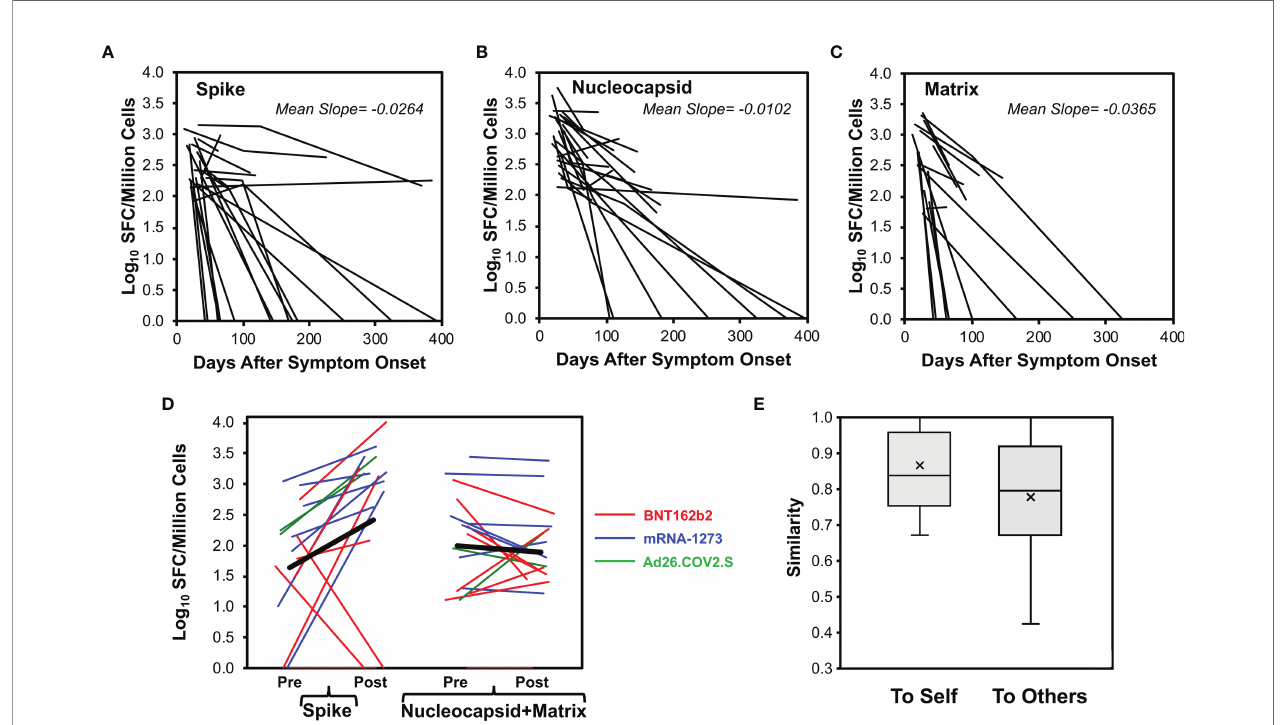
FIGURE 4 | CD8 + T cell responses decay after SARS-CoV-2 infection but vaccination boosts memory against spike protein. CD8 + T cell responses were measured longitudinally by ELISpot assay in 29 persons monitored starting early SARS-CoV-2 infection (23 with mild infection, 6 with severe infection, starting <45 days after symptom onset), serial measurements are plotted for 23 total spike responses (A) , 24 total nucleocapsid responses (B) , and 16 total matrix responses (C) . (D) For 17 persons with prior COVID-19 who were vaccinated with an available pre-vaccination measurement within 65 days (14 with mild infection, 3 with severe infection including one who had critical infection, vaccinated mean of 225 days post onset of symptoms, range 64 to 394 days), baseline pre-vaccination (mean of -21.9 days, range -63 to +3 days before vaccination) and resulting post-vaccination ( fi rst dose, mean of 12.8 days, range 5 to 29 days after vaccination) total response levels against spike and combined nucleocapsid plus matrix are plotted. Eight vaccinees received BNT162b2 (red), seven vaccinees received mRNA-1273 (blue), and two vaccinees received Ad26.COV2.S (green). Two non-responders had no detectable response at baseline and received BNT162b2. One non-responder had prior severe illness and the remainder had mild illness. (E) For the vaccinated persons, Sørenson similarity values were calculated between pre- and post- vaccination recognized spike pools within each person (self) and across all combinations with other persons (others). Box plots indicate 25th to 75th quartiles and medians, with medians (horizontal line) and means (x) marked. The high background similarity between individuals resulted from the high number of unrecognized pools (average 10.2/12 pools) and thus multiple shared unrecognized pools across